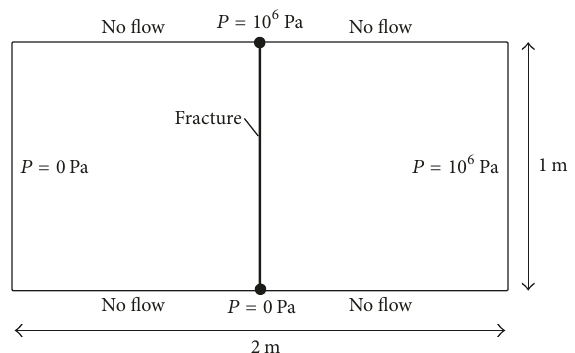
Figure 13: Dimensions and boundaries of the model with one fracture.